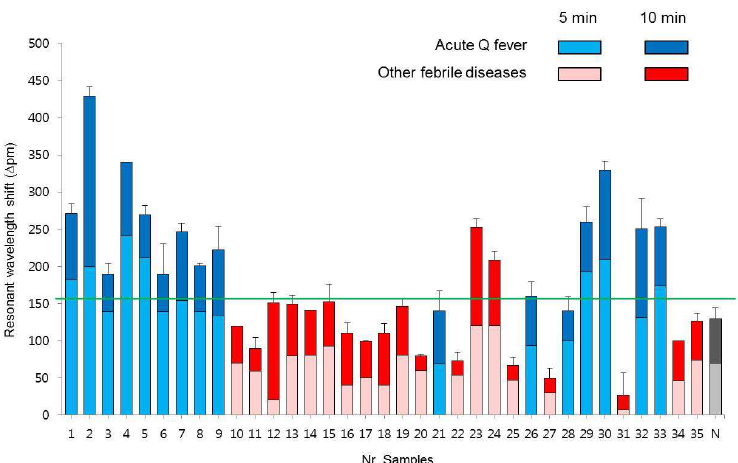
Figure 4. Clinical utility of the silicon microring resonator biosensor with 35 patient blood plasma specimens for the C. burnetii detection. The bar graph shows the resonant wavelength shift in 5 and 10 min. The blue bars indicate the result of 5 min (light blue) and 10 min (blue) of 16 samples of acute Q fever patients, and the red bars indicate the result of 5 min (light red) and 10 min (red) of 19 samples of other febrile diseases patients, while the gray bar indicates the result of 5 min (light gray) and 10 min (gray) of the healthy control. The green line indicates a criterion for positive and negative determination in 10 min. The error bars indicate the standard deviation of the mean, based on at least three independent experiments. Table 3. The clinical sensitivity and specificity of the SMR biosensor for Q fever diagnosis using 35 clinical specimens at 10 min.